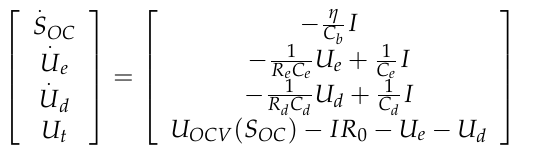
Figure 3. Generator testing bench .